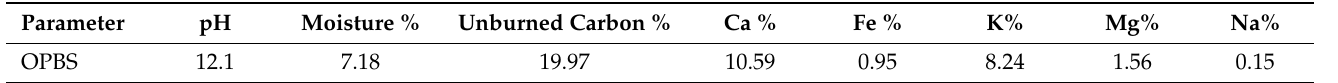
Table 2. pH, moisture content, unburned carbon, and major elements in